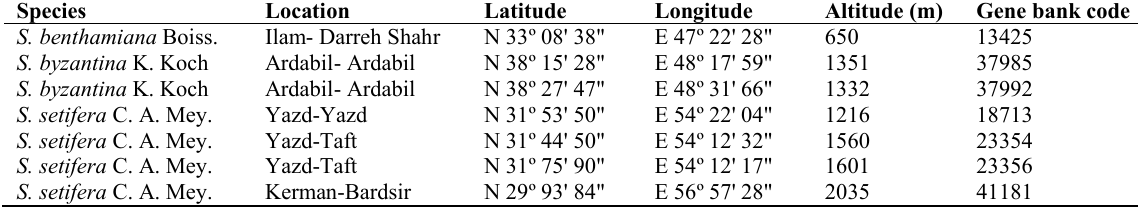
Table 1. Geographical information of the Stachys species investigated in the present study.